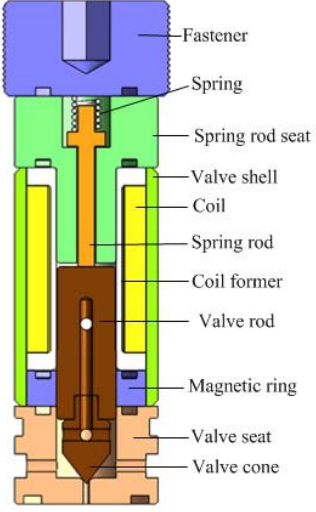
Table 3. Materials for each component of the miniature digital valve.